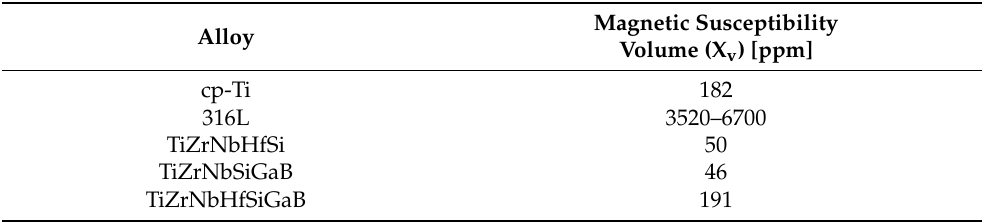
Table 10. Corrosion current density and magnetic susceptibility volume for TiZrNbHfSi,